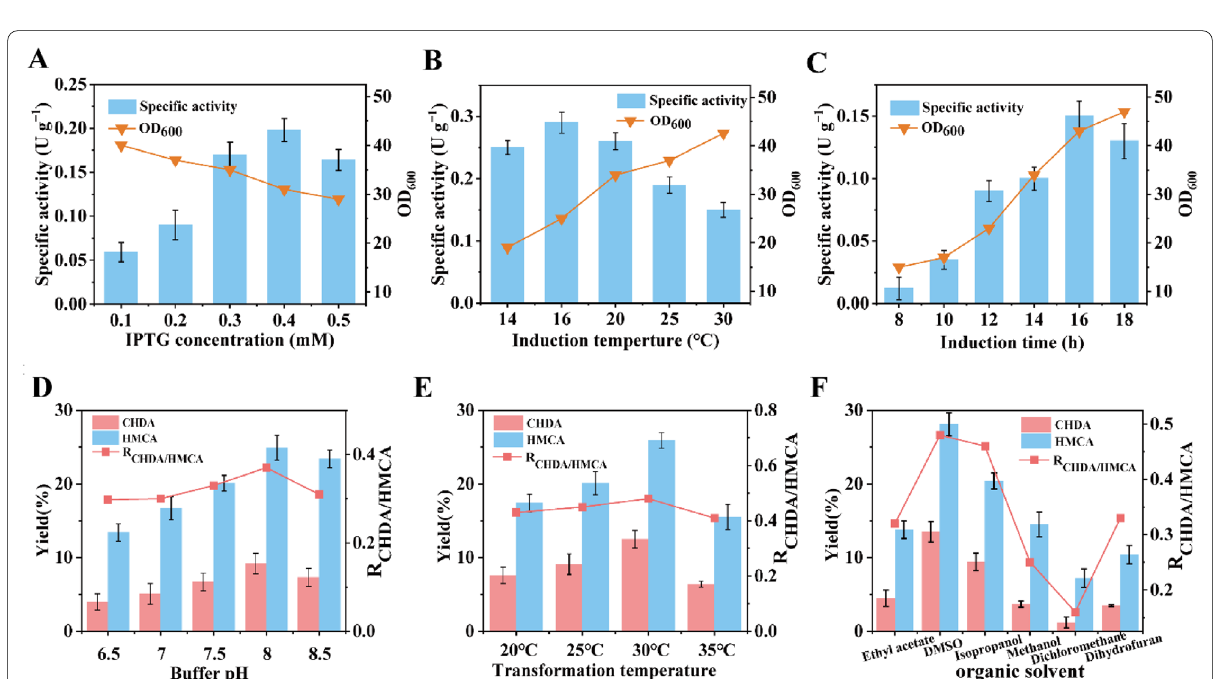
Fig. 1 Optimizations of the wild type Ac CO in induction and conversion process. A Effect of induction time on the specific activity and cell growth of the WT. B Effect of IPTG concentrations on the specific activity and cell growth of the WT. C Effect of induction temperature on the specific activity and cell growth of the WT. D Effect of buffer pH on the R CHDA/HMCA and the yield of CHDA and HMCA. E Effect of transfer temperature on the R CHDA/HMCA and the yield of CHDA and HMCA. F Effect of organic solvent type on the R CHDA/HMCA and the yield of CHDA and HMCA. The specific activity and yield were obtained through measuring the titer of CHDA and HMCA by GC